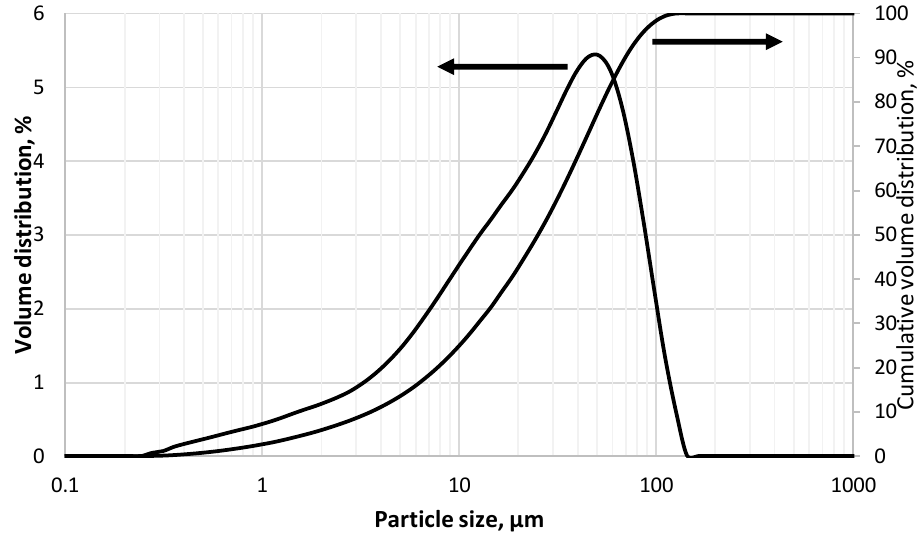
Figure 10. Size distribution of feed material for testwork as measured by a Malvern Mastersizer 3000